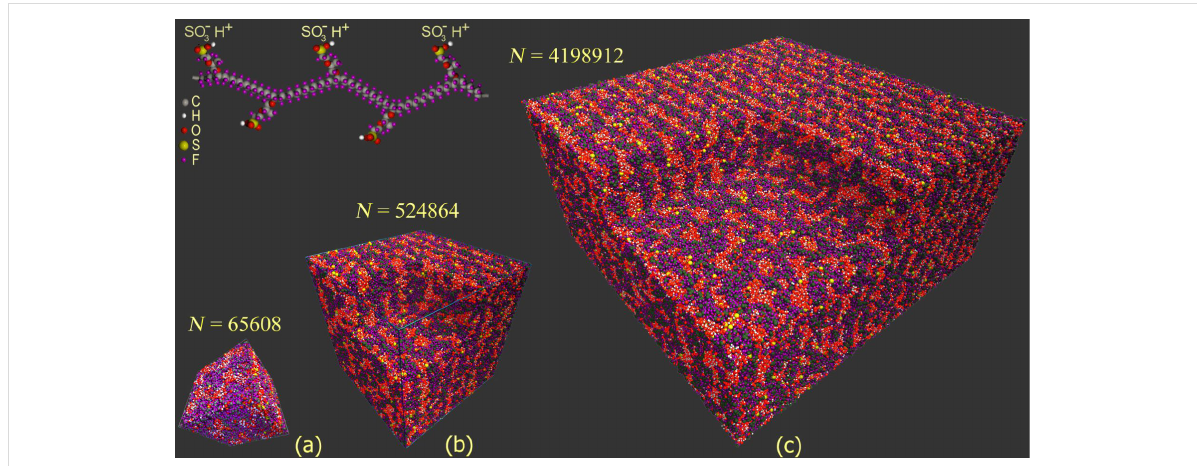
Figure 3: Typical structures predicted by fully atomistic molecular dynamics simulations for hydrated Nafion membrane (10 water molecules per SO 3 − group) and a fragment of Nafion chain. In the systems studied at ambient temperature and under atmospheric pressure (NPT ensemble), all SO 3 H groups are dissociated, while released protons are bound to water molecules to give hydronium ions H 3 O + . The total number of atoms N in a simula- tion box with periodic boundary conditions is specified for each system. A portion of materials is removed from the images of systems (b) and (c) for a better understanding of the structural organization. The evolution of each system was monitored for 200 ns after